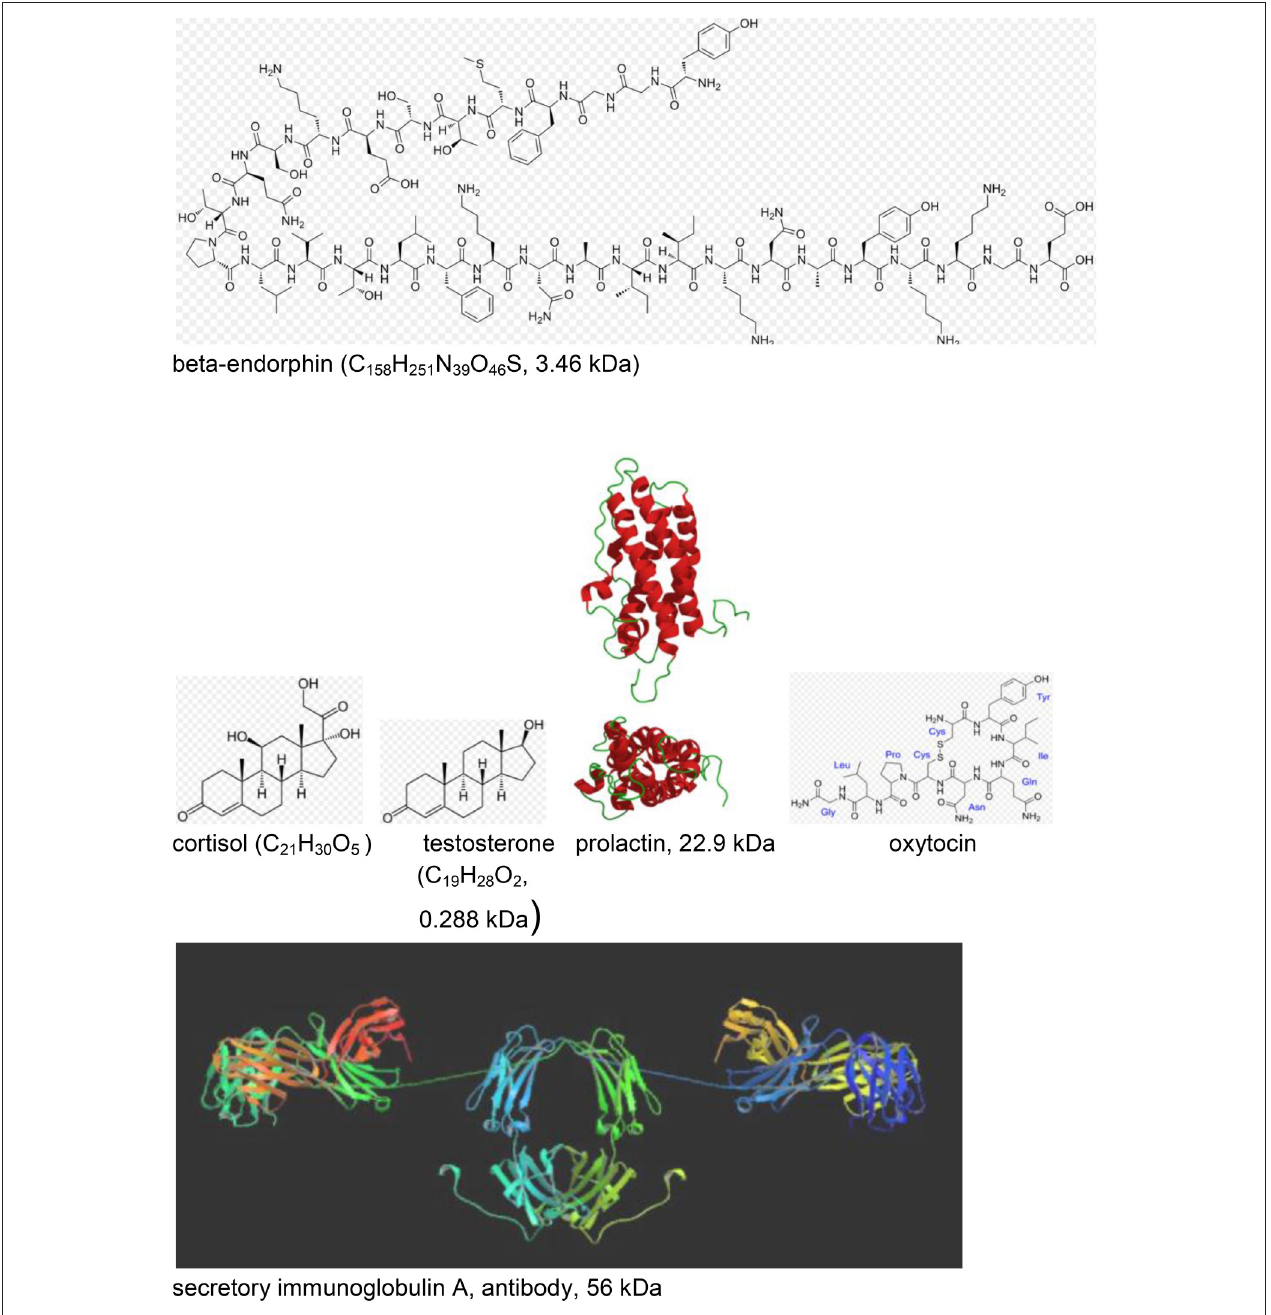
FIGURE 11 | Neuroendocrine and immunological molecular markers released during music- evoked emotion (see Kreutz et al., 2012). The molecular masses are given in kDa = 1.66 × 10 − 24 kg. http://en.wikipedia.org/wiki/Beta-endorphin#mediaviewer/File:Betaendorphin.png; http://de.wikipedia.org/wiki/Cortisol; http://de. wikipedia.org/wiki/Testosteron; http://de.wikipedia.org/wiki/Prolaktin; http://de.wikipedia.org/wiki/Oxytocin; http://en.wikipedia.org/wiki/Immunoglobulin_A downloads